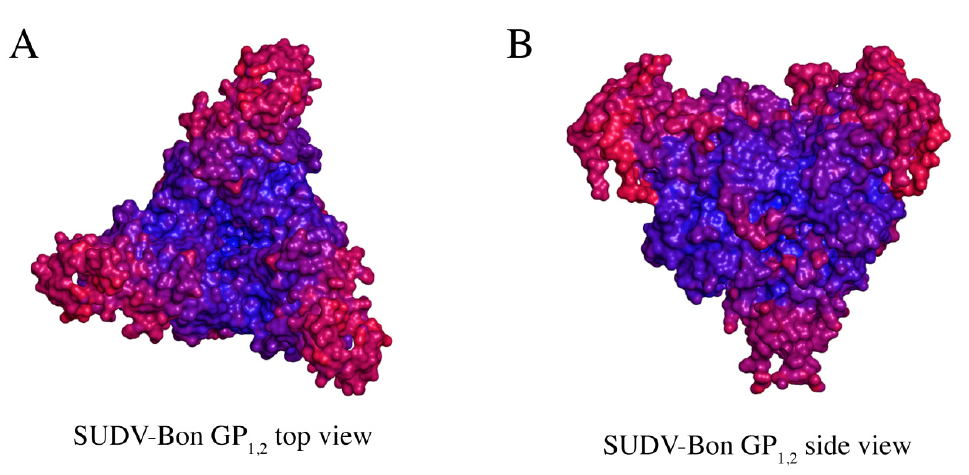
(Panels A Figure 5. Comparison of thermal factors (B-factors) of various regions of SUDV GP 1,2 and B). Regions of low thermal mobility are deep blue (deep blue color set at ~ 80 Å 2 ), whereas regions of high thermal mobility are red (deep red color set at ~ 220 Å 2 ). The glycan cap and C- have higher B-values than the core region, indicating terminal “stem” regions of SUDV GP 1,2 higher motion in those